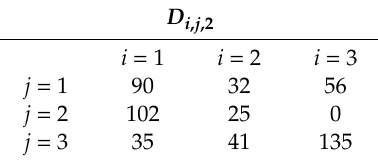
Table A2. Demand at period 2 (units).